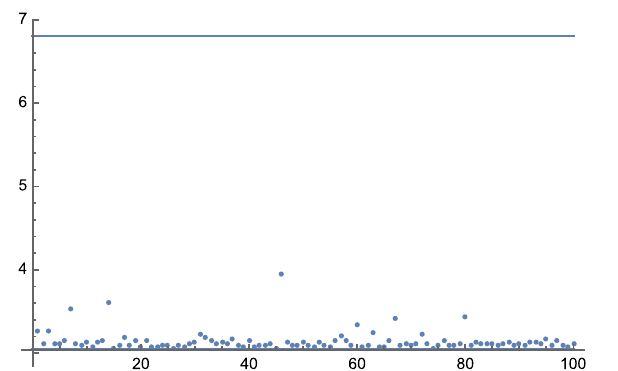
Fig. 12 The variances V [ F ] of Example 4 computed for 100 independent executions with the linear heuristic, using 100 samples for each technique. The horizontal lines correspond to the optimal and the equal sampling budget variances,